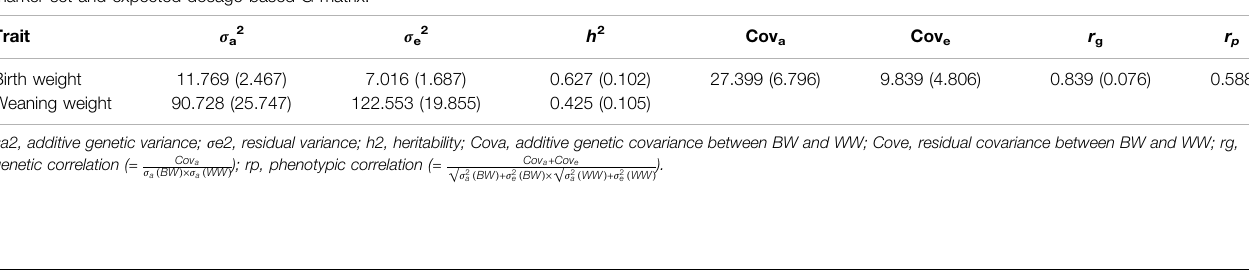
TABLE 3 | Accuracies and biases of genomic prediction and their standard errors (in brackets) under single-trait model with different marker sets. Marker set